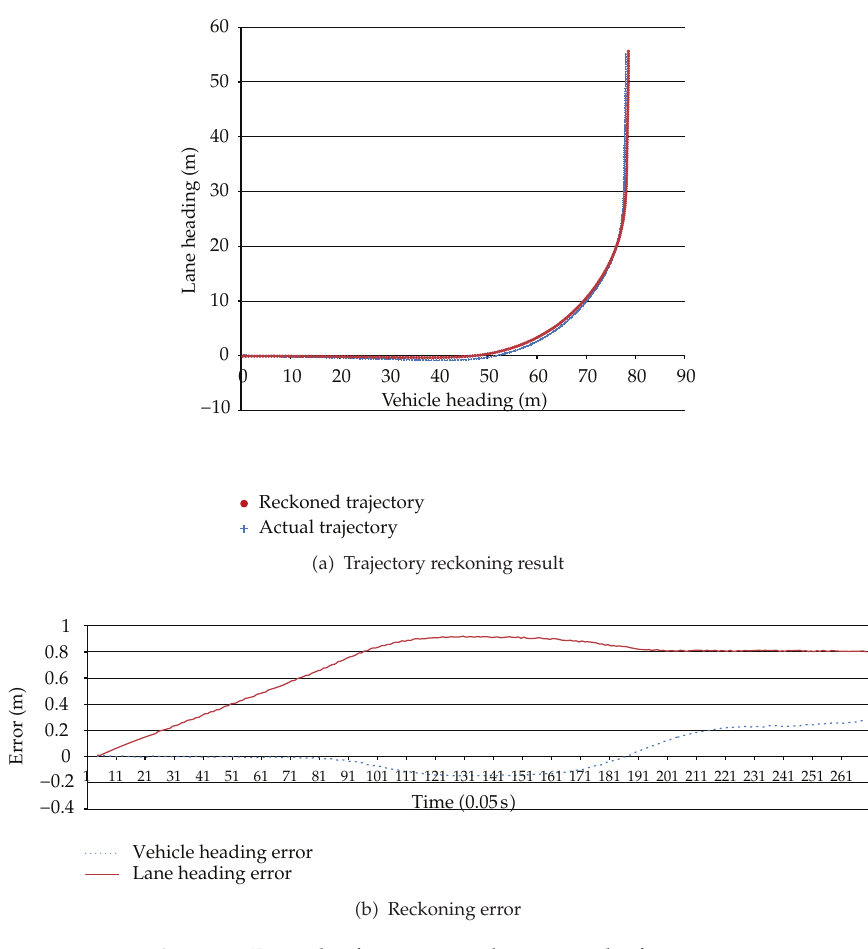
Figure 14: Example of trajectory reckoning result of turning. Table 5: Trajectory reckoning